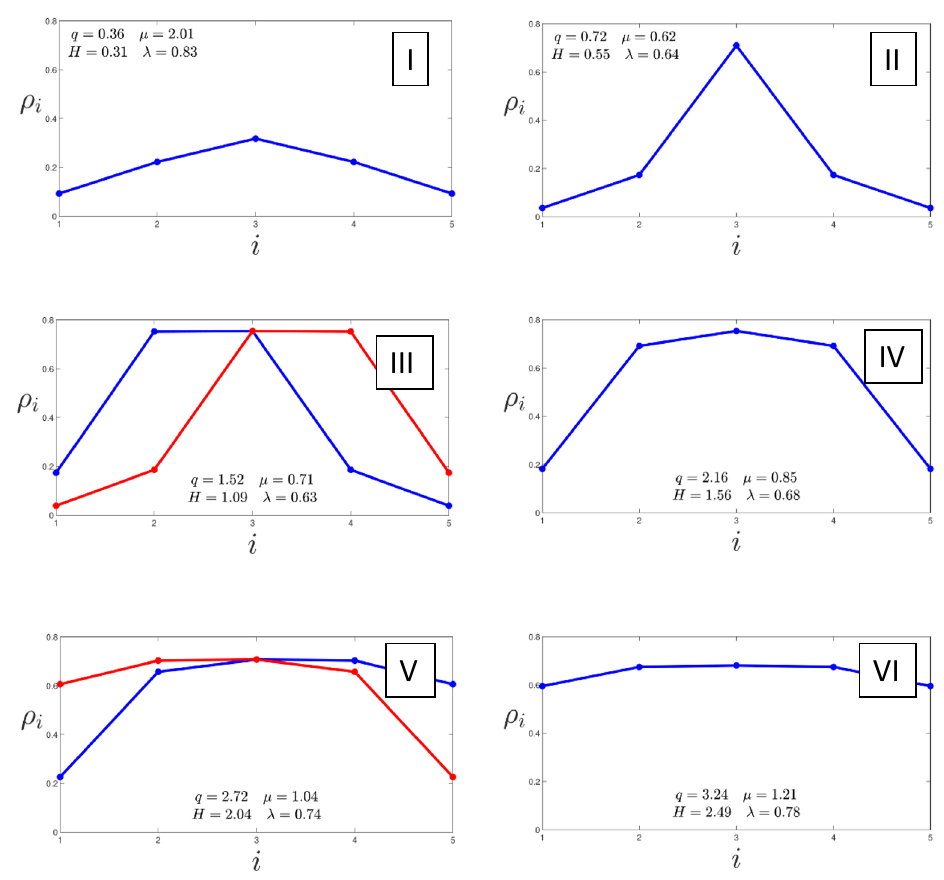
Figure 3 . Values of order parameter (4.12) for minimum energy con(cid:12)guration (4.9), (4.10) with di(cid:11)erent representative parameter values ( q; (cid:22) ) for a chain with N = 5 sites and with (cid:15) = 1 = 8. Panels I and VI do not describe a timecrystalline Q-ball; there is no domain wall. Panels II-IV are timecrystalline Q-balls with two domain walls; note that the blue and red pro(cid:12)les in Panel III are re(cid:13)ection symmetric under k ! 6 (cid:0) k . In Panel V we have a pair of k ! 6 (cid:0) k re(cid:13)ection symmetric timecrystalline single domain wall